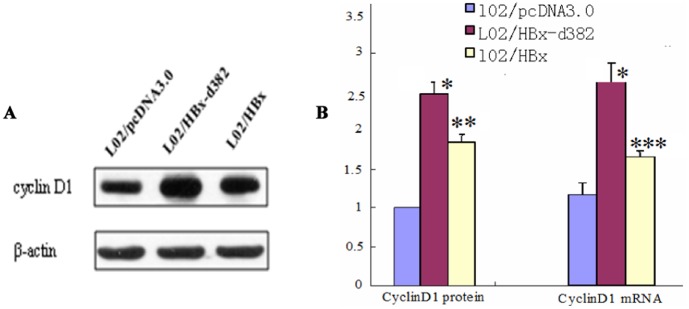
HBx, especially HBx-d382, enhances CyclinD1 expression.(A) CyclinD1 protein level of the engineered LO2 cells. (B) The histogram of CyclinD1 mRNA and protein level in LO2/HBx and LO2/HBx-d382 cells, compared with LO2/pcDNA3.0 cells (*P<0.001,**P = 0.017,***P = 0.029).